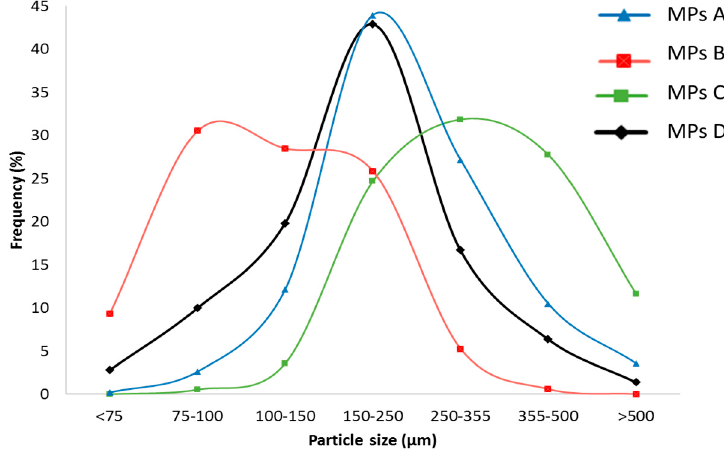
Figure 5. Particle size distribution of the microparticle formulations.